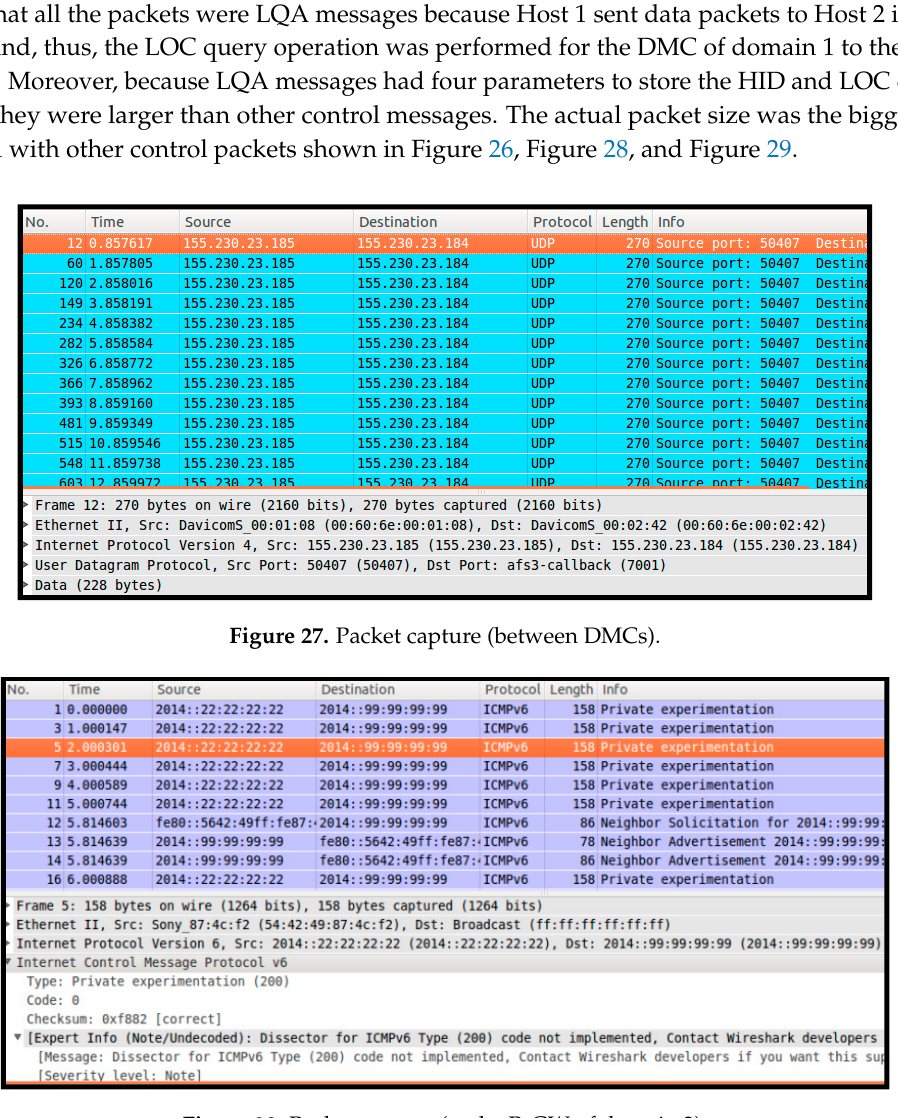
Figure 28. Packet capture (at the R ‐ GW of domain 2).